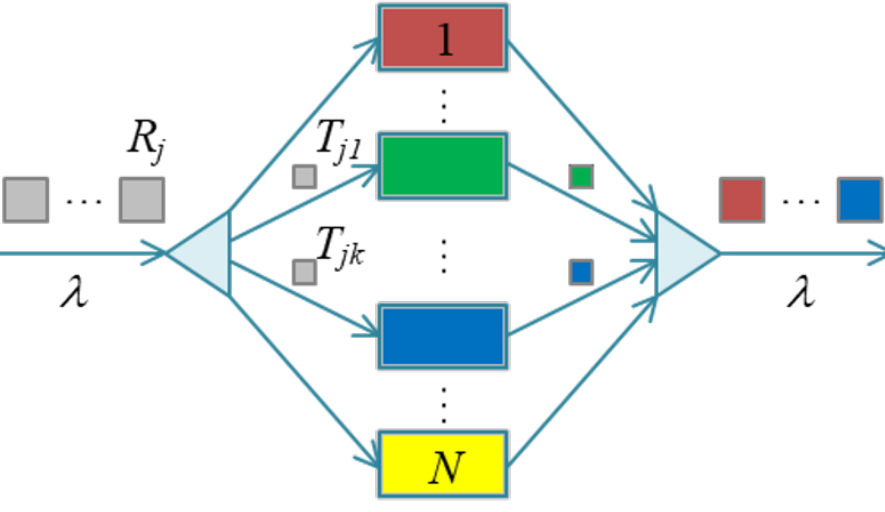
Figure 1. Simulation model for inhomogeneous scenarios, where incoming requests spawned to an equal number of fork nodes at a